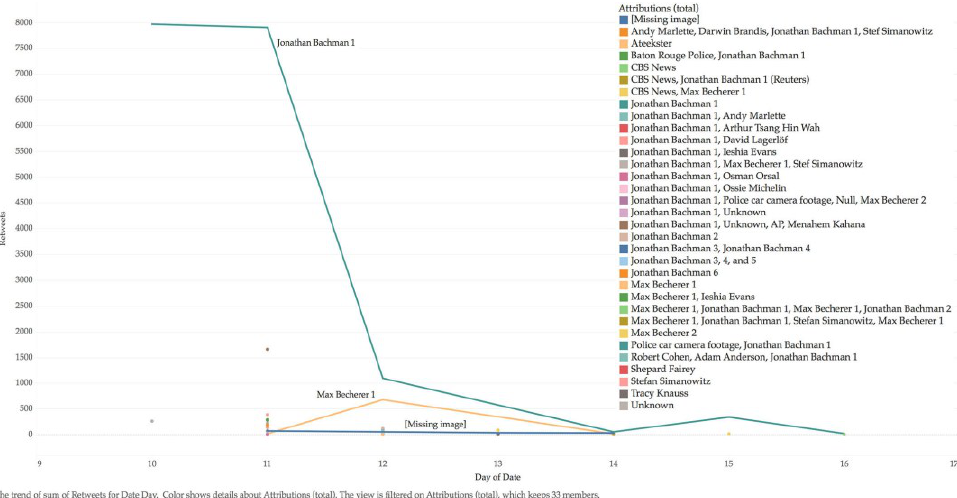
Figure 3. Sharing images of Ieshia Evans over the period 9–16 July 2016, demonstrating the utter dominance of Jonathan Bachman’s photograph in the dataset. Chart developed in Tableau.